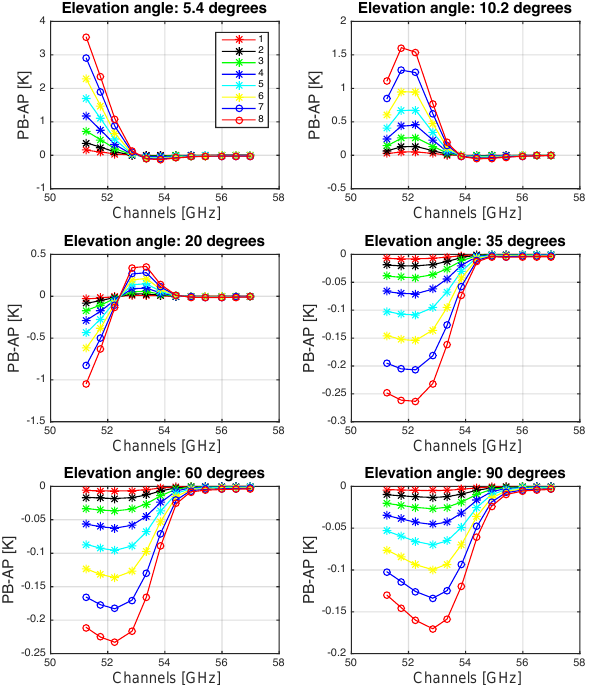
Figure 10. Errors associated with the bandwidth for different fre- quencies and elevation angles. The biases have been calculated as the Tb s considering the monochromatic receiver minus the Tb s as- suming different bandwidths (from 100 to 1000MHz). nier et al. (2013), and it is linked to a change in the curvature of the Tb vs. angle